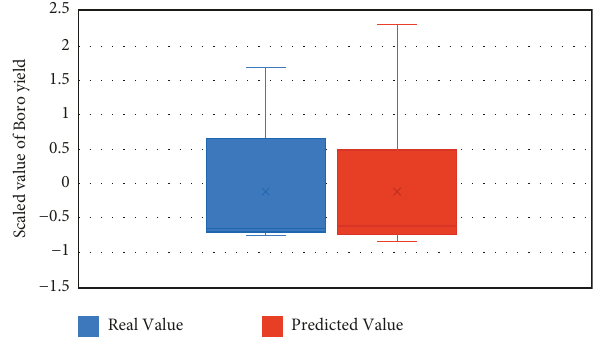
Figure 25: Comparison between real values and predicted values of Boro yield for SVR using box plot. Table 7: RMSE and r 2 value after Boro yield prediction.